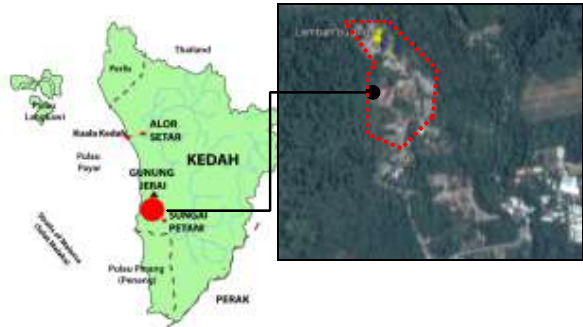
Figure 1 : Location map of Lembah Bujang archaeological site.